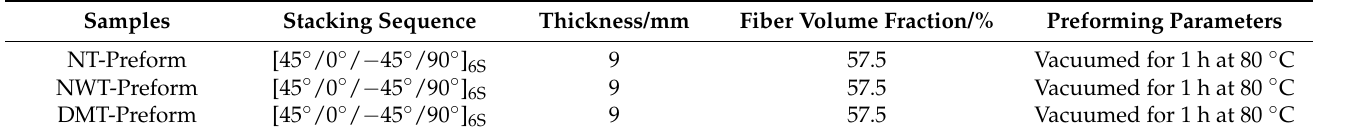
Table 1. Lay-up sequence and manufacturing process of unidirectional carbon